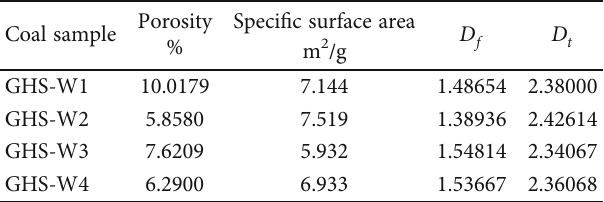
Table 3: Fractal dimensions of the tree fractal model. Porosity Coal sample